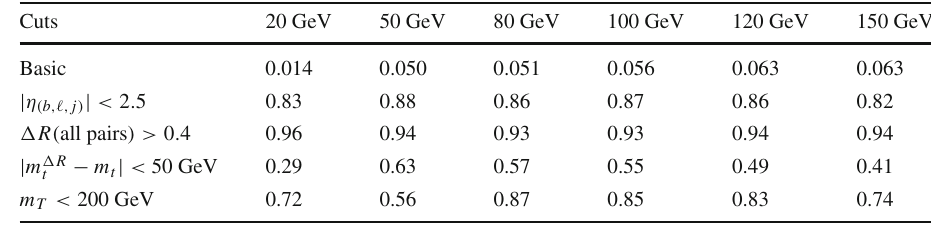
Table 3 Efficiency after each cut for the six dominant backgrounds. SL (LL) denotes semi (di)-leptonic decays